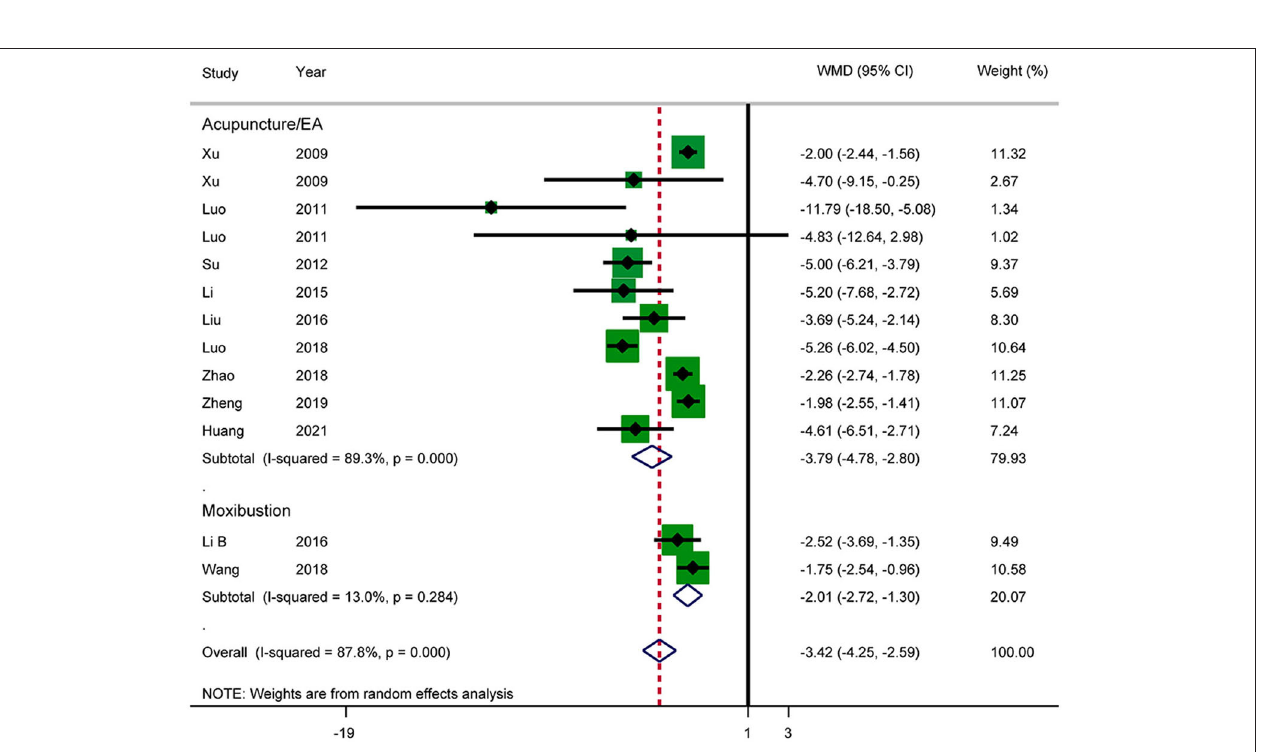
FIGURE 10 | Meta-analysis of length of hospital